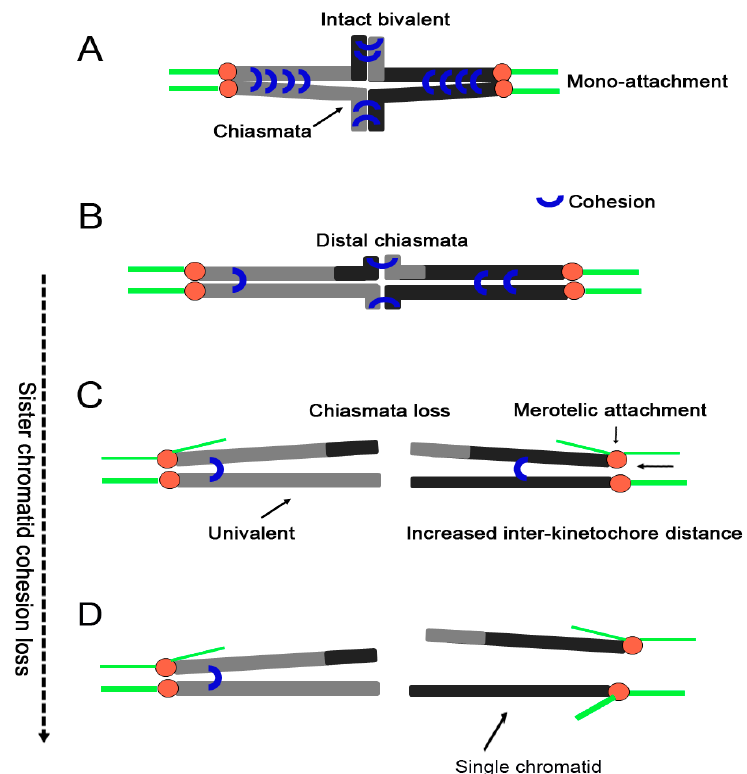
Figure 3. The effects of age-related cohesion loss. ( A ) An intact bivalent configuration is attached by an amphitelic microtubule bundle. The two sister chromatids of each homologous chromosome face towards the same spindle pole. The cohesion embraces the two sister chromatids at their centromeres and along the chromosome arm; ( B ) The chiasmata shift toward the distal chromosome with cohesion loss; ( C ) A bivalent configuration becomes two univalents at the time of chiasmata loss, which gives rise to arm cohesion deterioration; ( D ) Centromere cohesion loss can generate a single chromatid in oocytes. Centromere cohesion loss can cause an increase in sister inter-kinetochore distance, as well as the merotelic attachment of a sister kinetochore and the appearance of a single chromatid. Red circle, centromere; green line, microtubule.